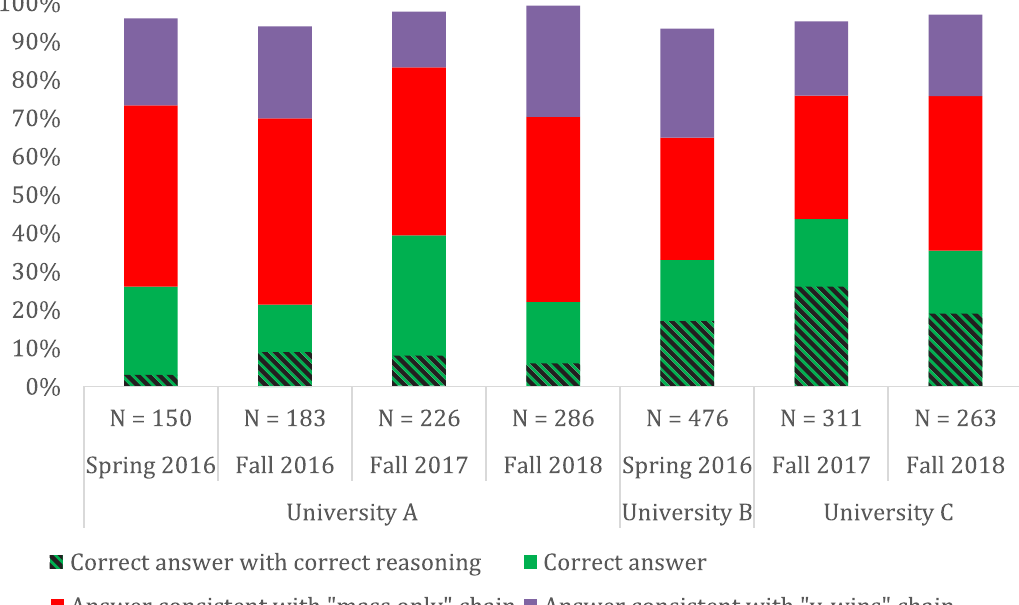
FIG. 5. Student responses on the base work-energy task. Shaded areas represent correct answers supported with correct reasoning. All other regions represent answers only, irrespective of the reasoning given. Totals do not sum to 100% because answer choices not aligned with one of the fictitious students are not included.